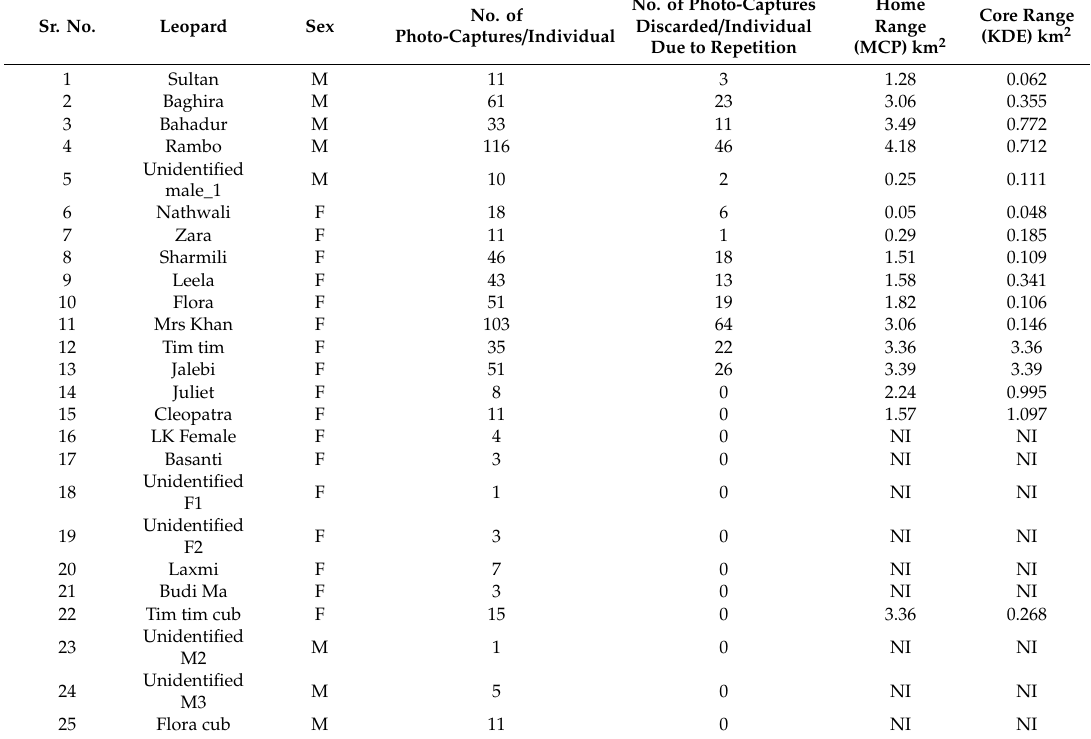
Table 1. List of the identified leopards of Jhalana Reserve Forest, indicating the number of photographs used / discarded for identification and estimation of home ranges (minimum convex polygon method, MCP) and core areas (fixed kernel density method, KDE). NI denotes “Not identified”. Sr. No. Leopard Sex